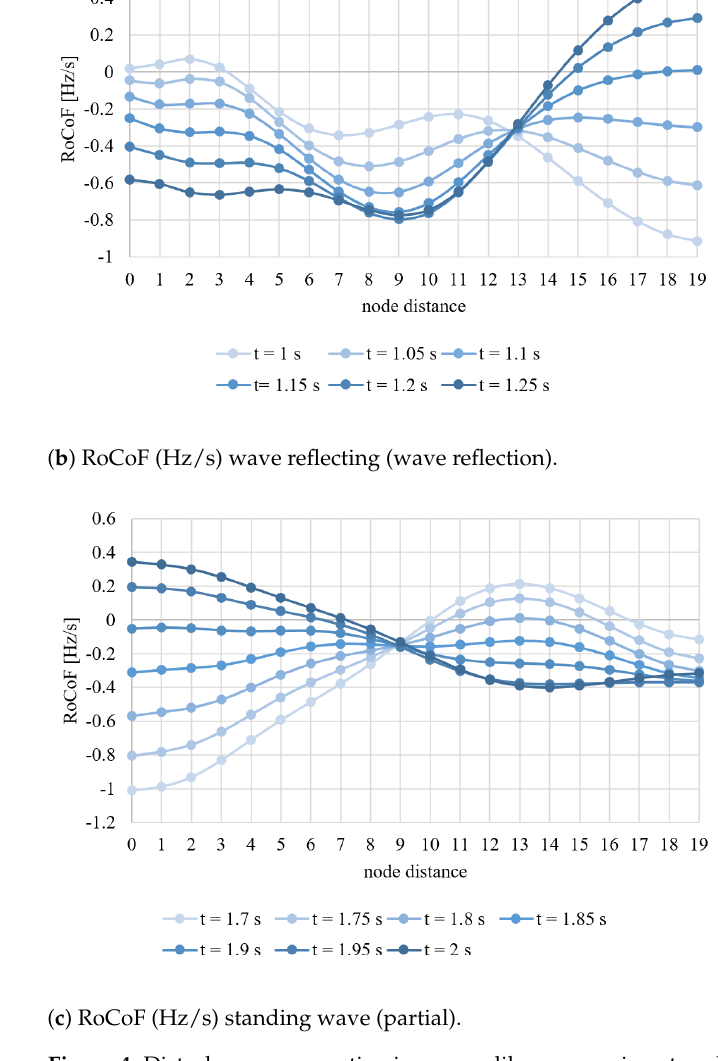
Figure 4. Disturbance propagation in a wave-like manner, in network G1, following a disturbance at node 0 (boundary node). ( a ) Transverse wave, ( b ) wave reflection, and ( c ) standing (partial)